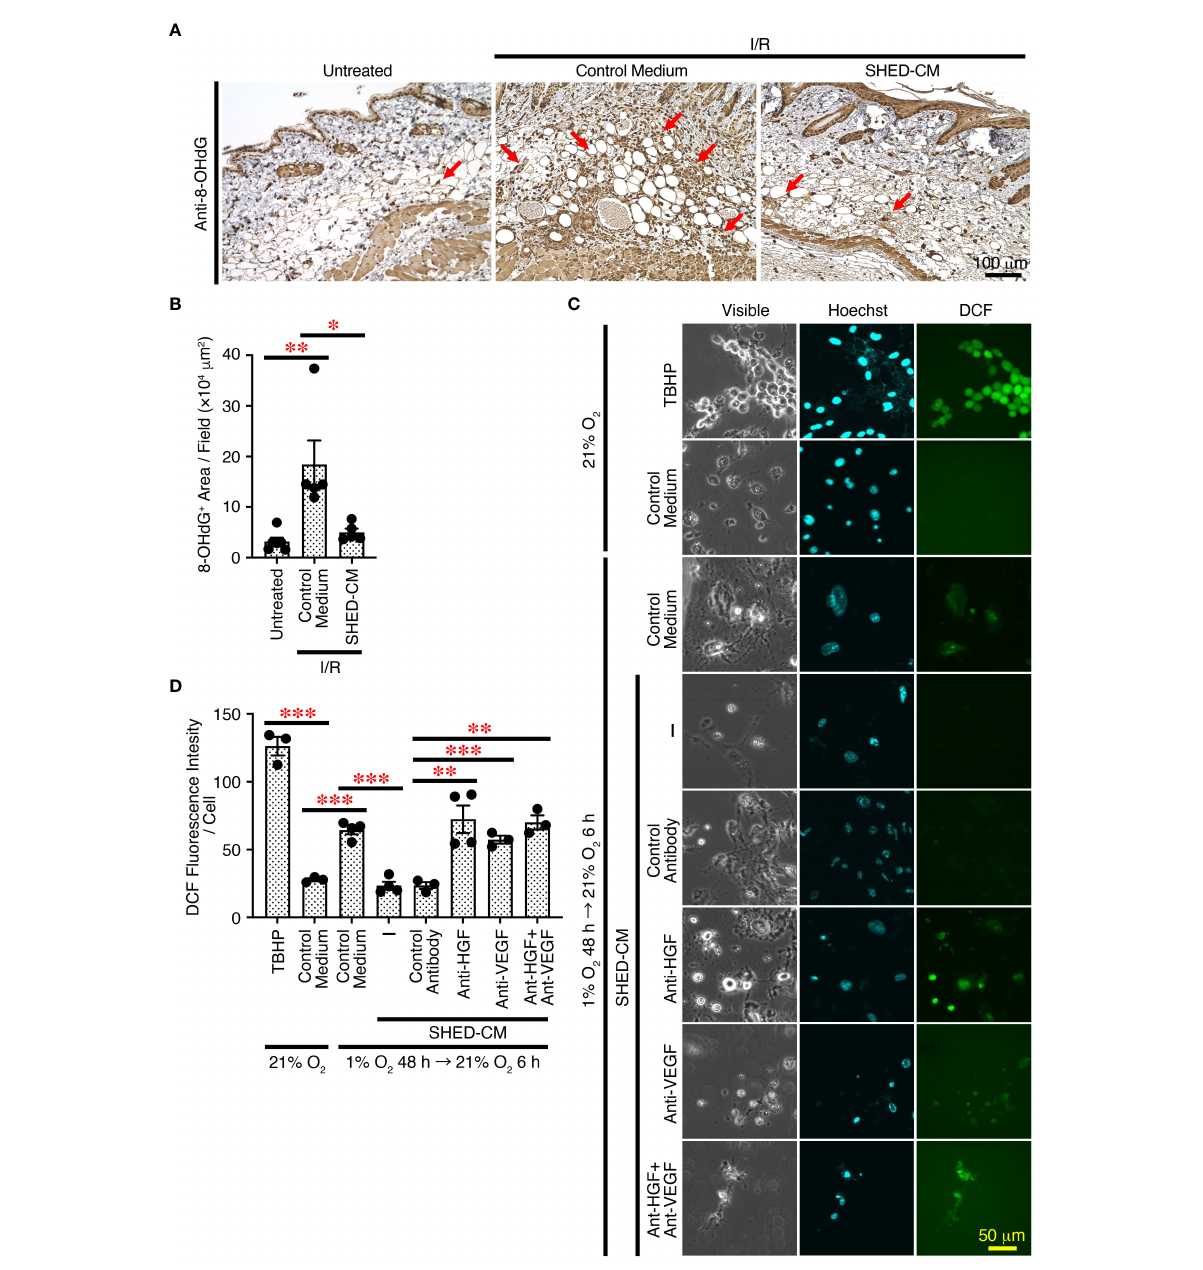
FIGURE 7 SHED-CM suppresses ROS generation through VEGF and HGF. (A) Mouse dorsal epidermal tissues of ulcers were removed on day 4 and immunohistochemically analyzed for expression of the oxidative stress marker 8-OHdG counterstaining with Mayer ’ s hematoxylin. Representative photographs for 8-OHdG are shown. Subcutaneous adipose tissue, sebaceous gland, hair bulb, dermis and epidermis were positively stained. (B) Positive areas for 8-OHdG were calculated using FIJI. Data are shown as the mean ± SEM (n = 5~6) and are representative of two independent experiments. (C) The effects of SHED-CM on ROS generation induced by hypoxia/reoxygenation in vitro was examined. NIH3T3 cells were incubated under hypoxic condition (1% O 2 , 5% CO 2 , and 94% N 2 ) for 48 h in the medium containing 1% FBS, and reoxygenation was then performed under normal ambient O 2 conditions (21%) in the presence of the SHED-CM, control medium, or VEGF- or HGF-depleted SHED-CM with respective antibodies, control antibodies-treated SHED-CM. After 6 h, cells were counterstained with Hoechst and analyzed for intracellular ROS production. Representative photographs of the ROS generation are shown. (D) The fl uorescence intensity of DCF was quanti fi ed using FIJI and calculated as arbitrary unit per cell. Data are shown as the mean ± SEM in triplicate and are representative of two independent experiments. P values were determined by the one-way analysis of variance with the Tukey multiple comparisons test. * P < 0.05, ** P < 0.01, *** P <